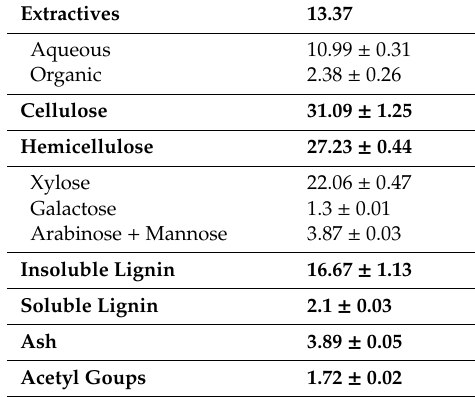
Table 1. Composition analysis (wt.%) of samples of barley straw dried at 105 ◦